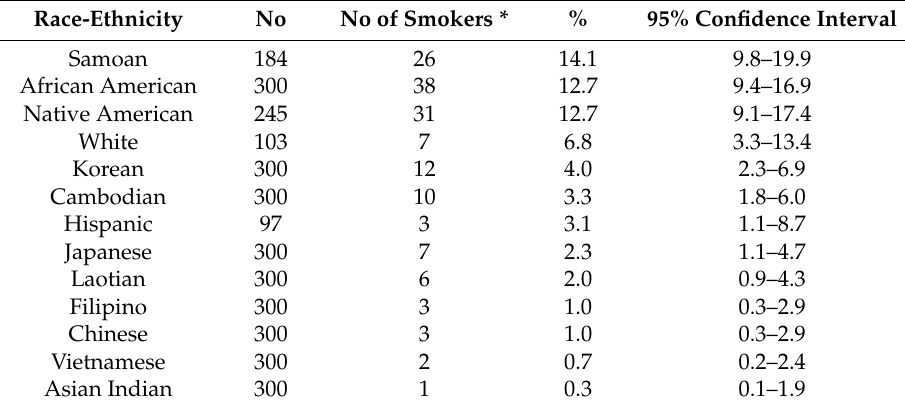
Table 2. Smoking prevalence (95% confidence interval) during mid-pregnancy for prenatal screening program enrollees in 13 race/ethnicity groups; San Diego, Orange and Imperial counties; by descending prevalence (N = 3329). Race-Ethnicity No No of Smokers * % 95% Confidence Interval Samoan 184 26